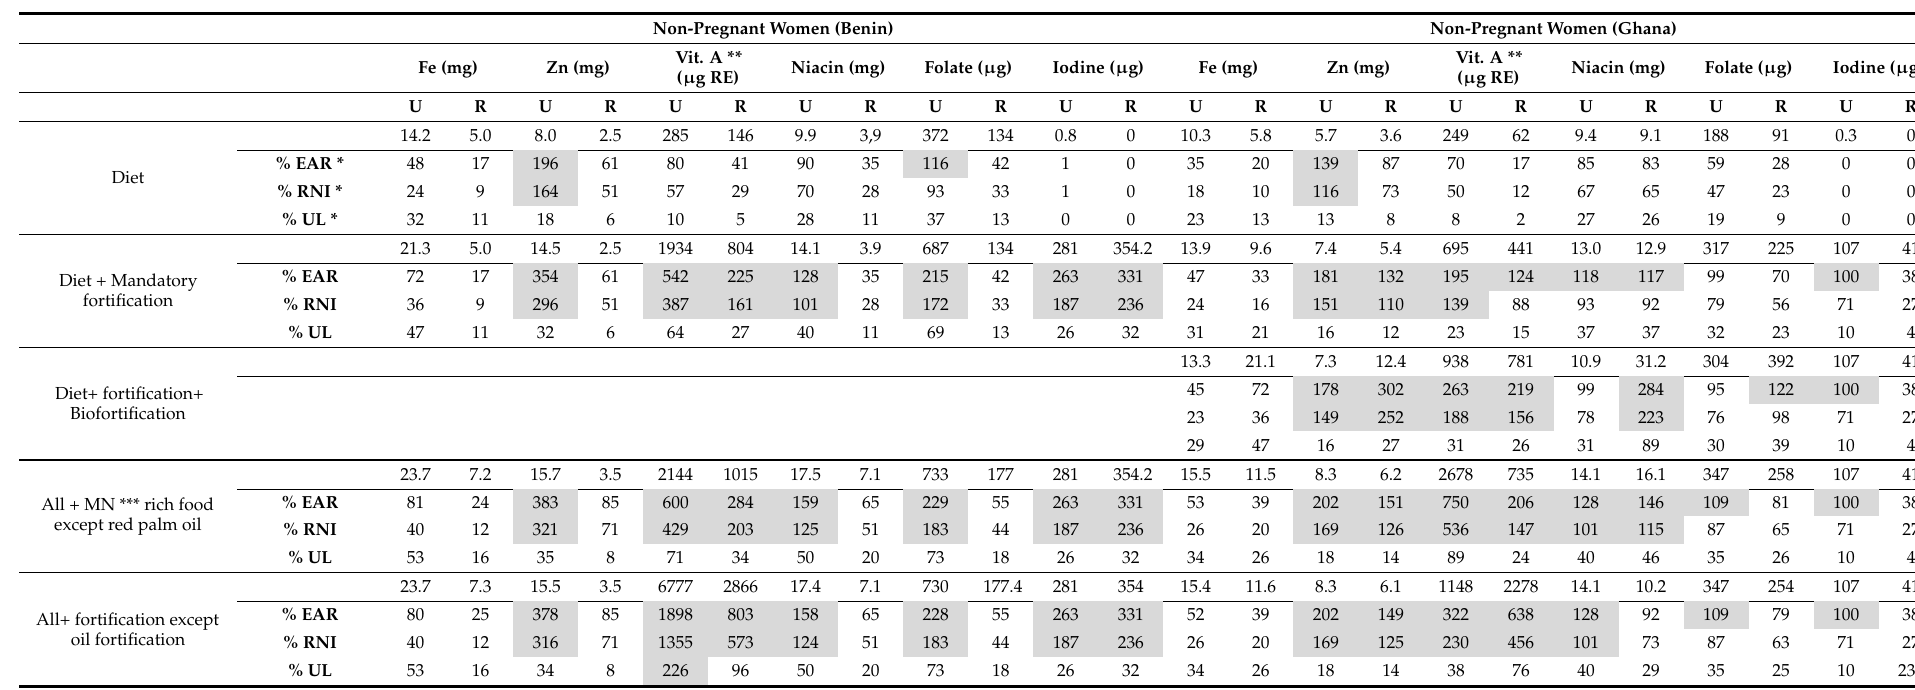
Table 3. Micronutrient intakes from diet and interventions and coverage of recommendations for non-pregnant, non-lactating women in Benin and Ghana in urban (U) and rural (R) settings. Shaded cells indicate when recommendations or limits are